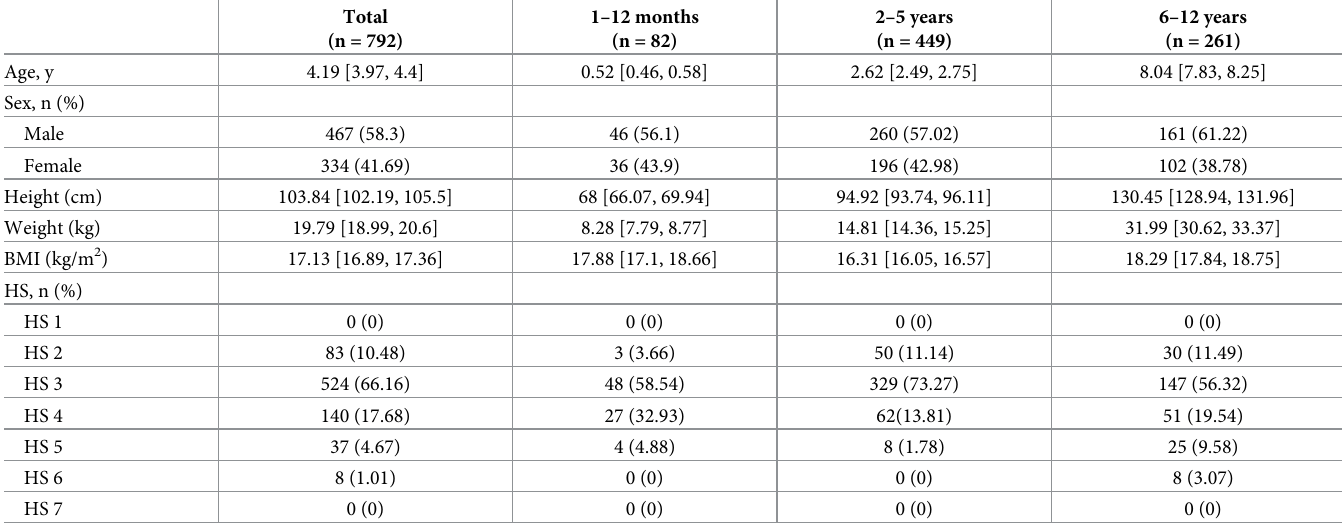
Table 1. General characteristics of the participants.